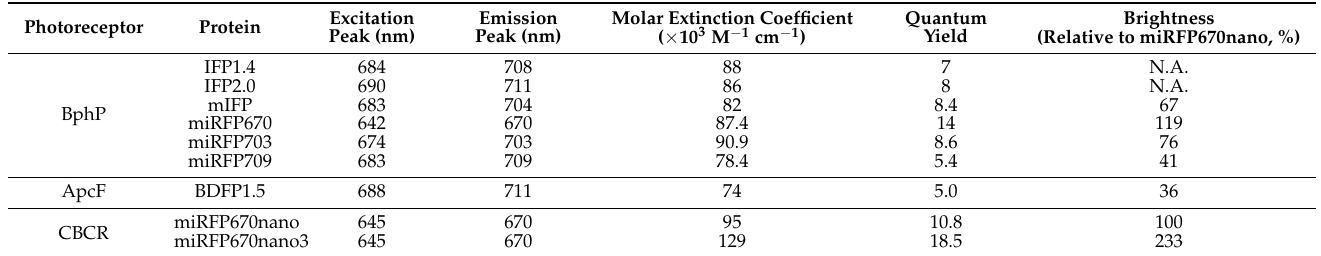
Table 2. Photophysical properties of NIR